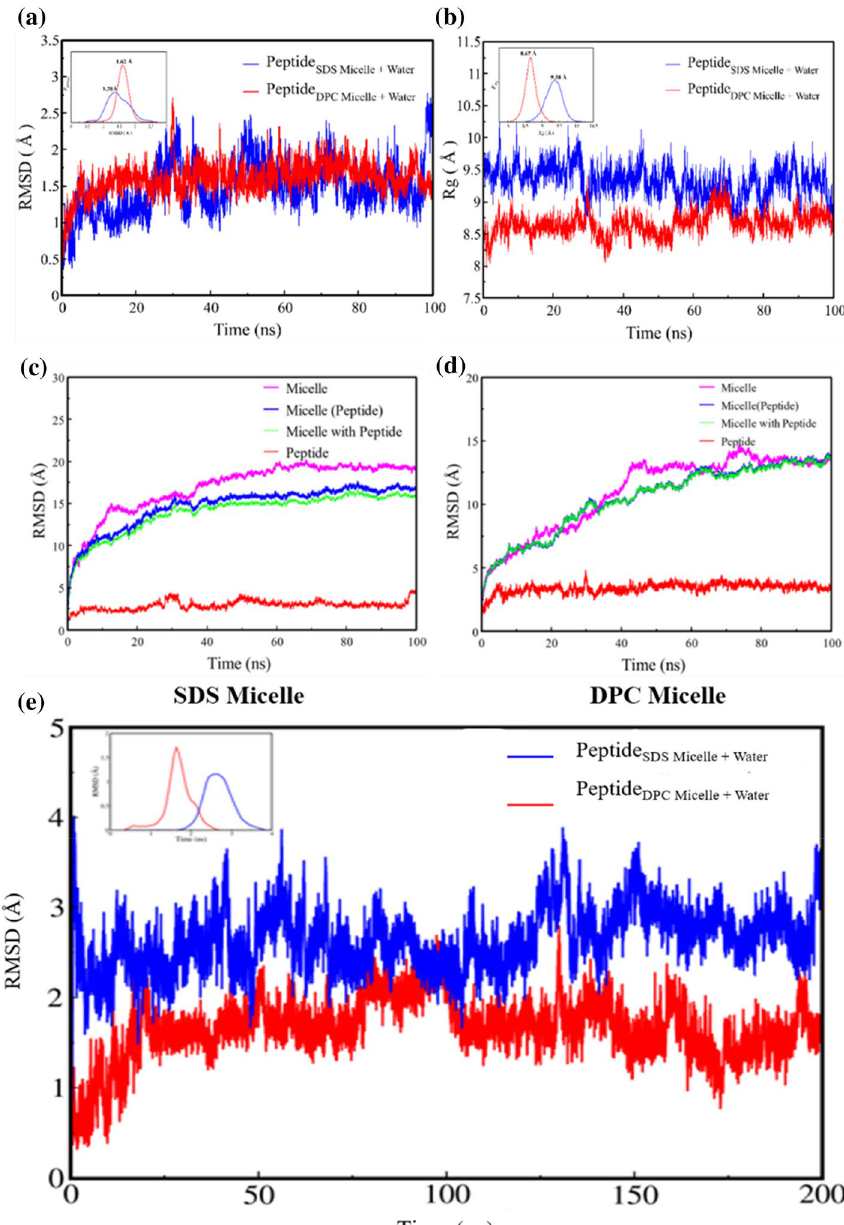
Figure 2. Conformational (RMSD) movement ( a ), and radius of gyration of the peptide, DP1 in SDS-water micelle complex and DPC-water micelle complex ( b ). Conformational (RMSD) movement of SDS (c) and DPC micelle ( d ) in the absence, presence, and the micelle complex with the peptide. Peptide backbone RMSD plotted for the entire 200 ns production dynamics ( e